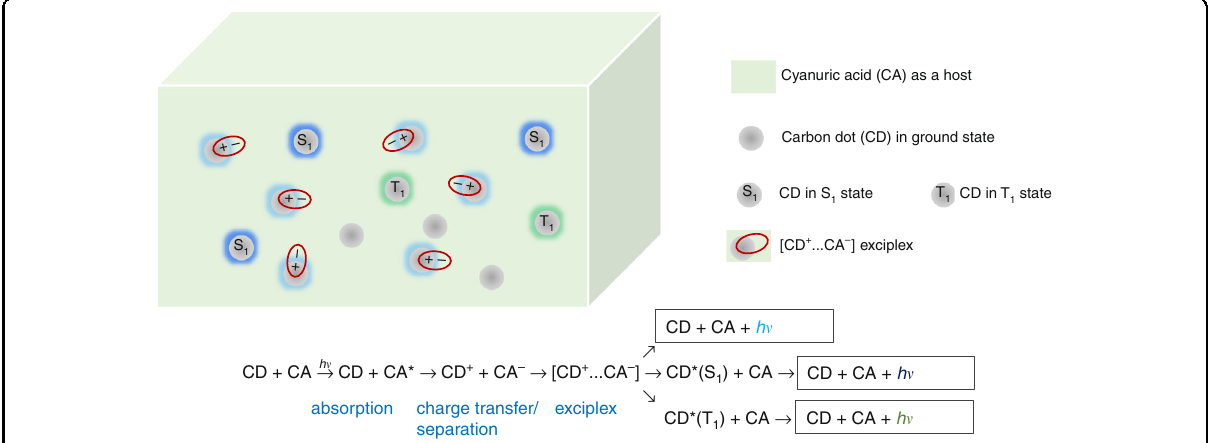
Fig. 1 The sequential process leading to formation of exciplex and multi-color long-persistent luminescence (LPL) from carbon dots embedded in cyanuric acid 7 . The color along the rim of a carbon dot in its singlet (S 1 )- and triplet (T 1 ) excited states, or exciplex state indicates the approximate color of the corresponding